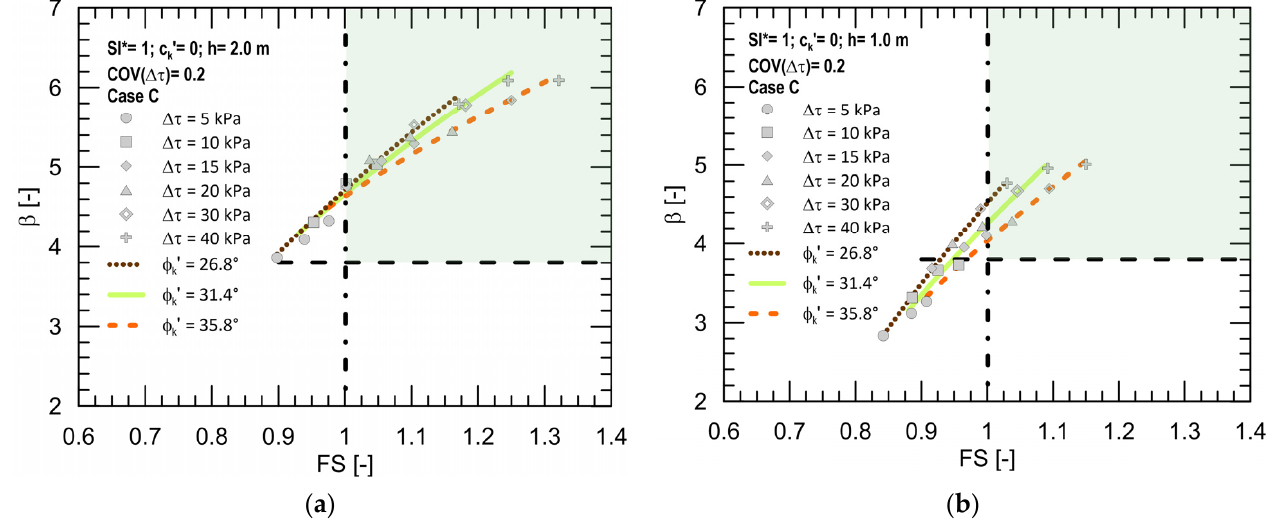
Figure 8. β - FS curves for varying ∆ τ and α - φ k (cid:48) combinations, for seismic case C and COV ( ∆ τ ) = 20%, Figure 8. β ‐ FS curves for varying  τ and α ‐ ϕ k ′ combinations, for seismic case C and COV (  τ ) = in case of h r = 2 m ( a ) and h r = 1 m ( b ), respectively. 20%, in case of h r = 2 m ( a ) and h r = 1 m ( b ), respectively.